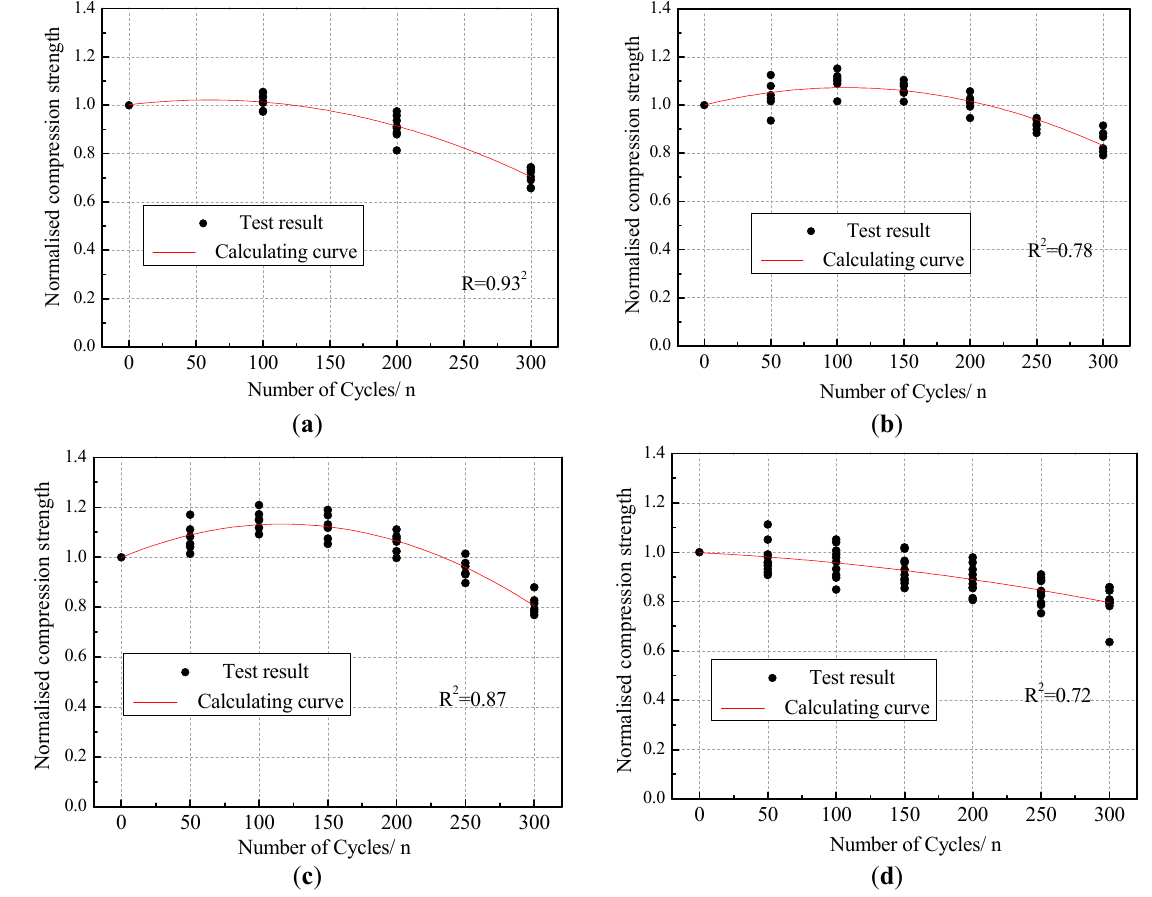
Figure 16. The compressive strength attenuation model of mortars and brick. ( a ) Cement-lime mortar prism. ( b ) Cement mortar prism. ( c ) Cement-fly ash mortar prism. ( d ) Brick unit.